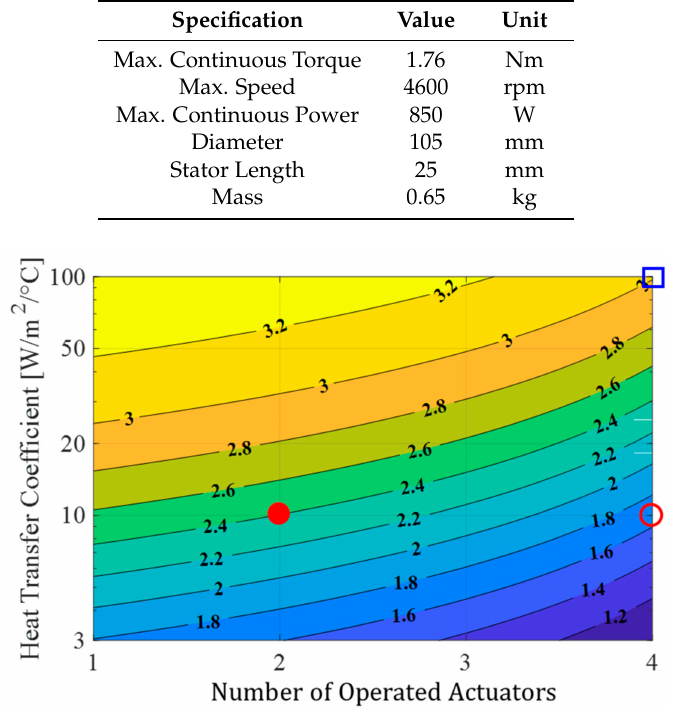
Figure 10. Contour plot of κ ss against the number of operated actuators of the 4-CoSMo, and heat transfer coefficient from the simulation. Here, the red-filled circle, red-empty circle and blue square mean that κ ss is about 2.4, 1.6 and 3,